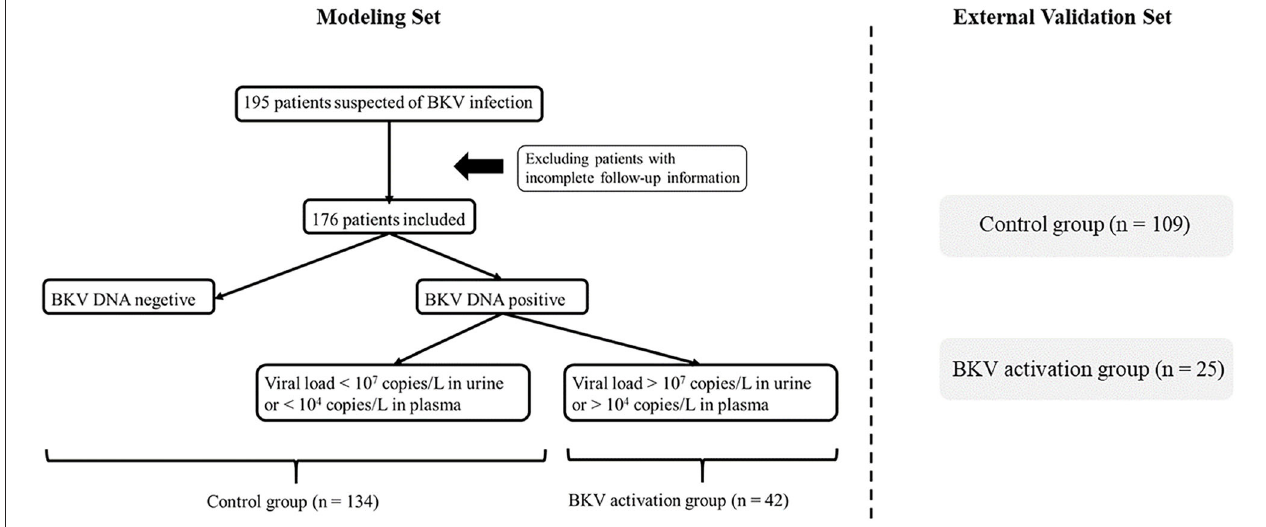
FIGURE 1 | Flowchart of patient enrollment. After deleting invalid cases through the exclusion criteria, 176 patients were enrolled and divided into the BK virus (BKV) activation group ( n = 42) and the control group ( n = 134) according to BKV-DNA levels in plasma and urine.